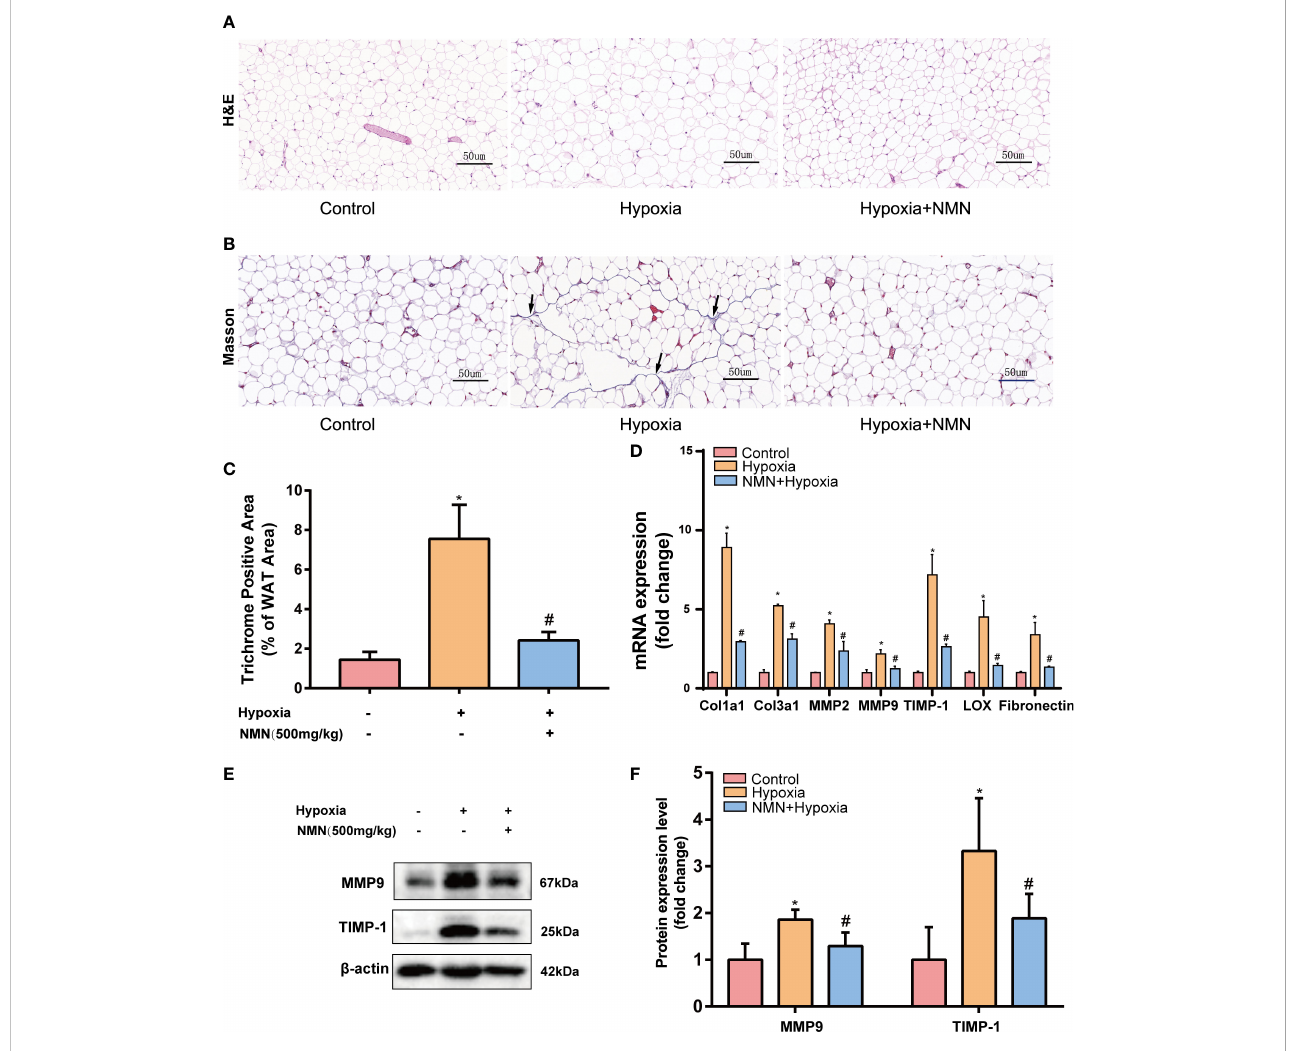
FIGURE 1 NMN alleviates the abnormal degradation and synthesis of ECM components in the eWAT of hypoxia-induced mice. (A, B) Representative images of eWAT adipocytes morphology and fi brosis as re fl ected by the H&E staining and Masson staining (400×magni fi cation, scale bar=50 m m). (C) Statistical result for the interstitial fi brosis of eWAT (n = 6). (D) The relative mRNA levels of Col1a1, Col3a1, MMP-2, MMP-9, TIMP-1, LOX, and FN normalized to b -actin in eWAT (n = 3). (E, F) The relative protein levels of MMP9 and TIMP1 normalized to b -actin in eWAT (n = 5). * P < 0.05 versus control group, # P < 0.05 versus hypoxia